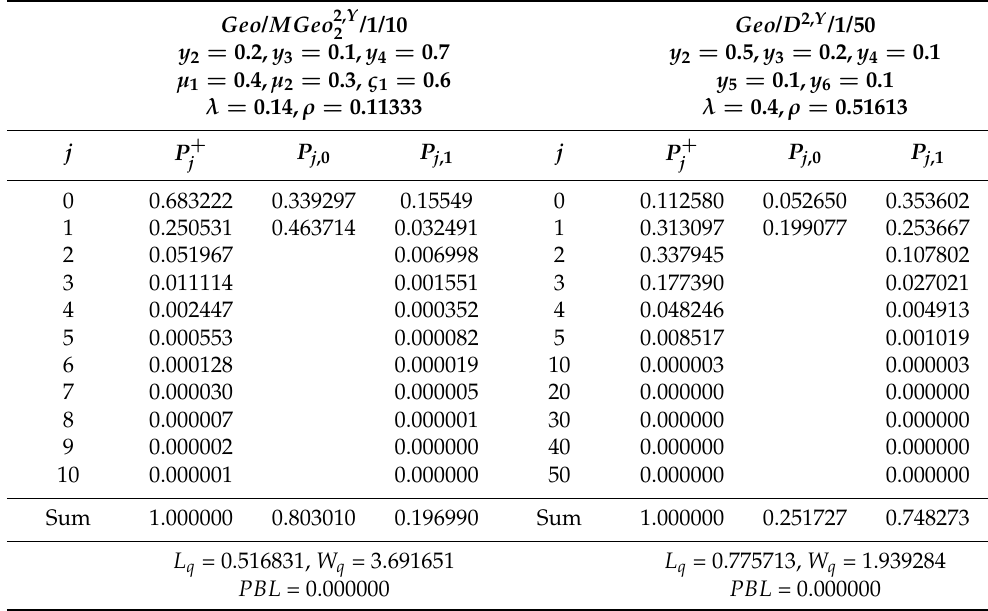
Table 3. Queue-length distributions at various epochs for the Geo / MGeo 2, Y Geo / D 2, Y /1/50